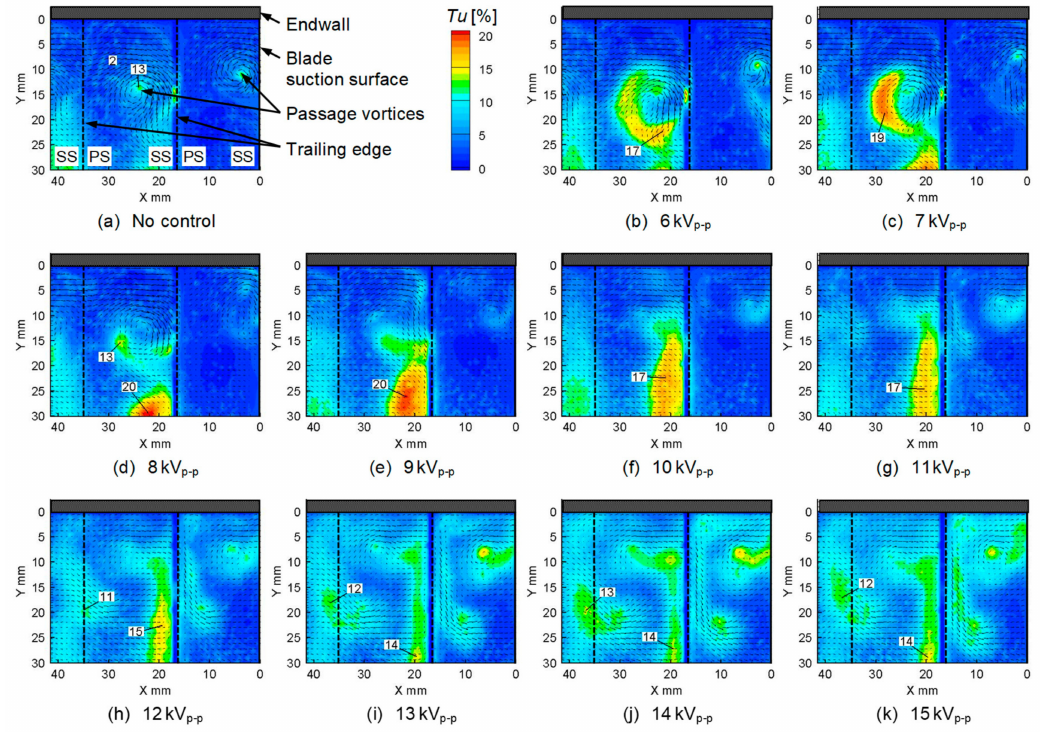
Figure 13. Turbulence intensity distributions at the outlet of the linear turbine cascade at various input voltages ( U FS , out = 2.4 m /